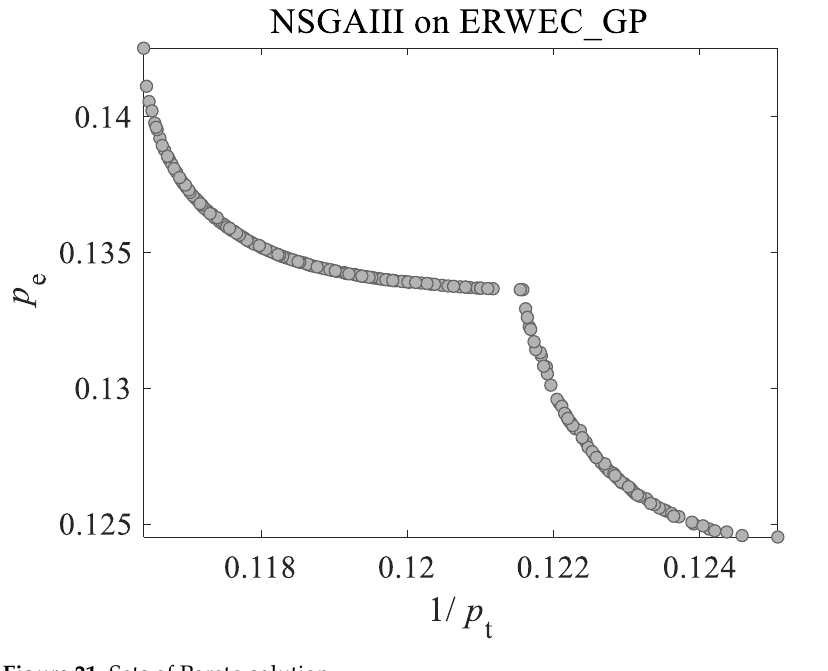
Figure 20. Flowchart of NSGA-Ш.